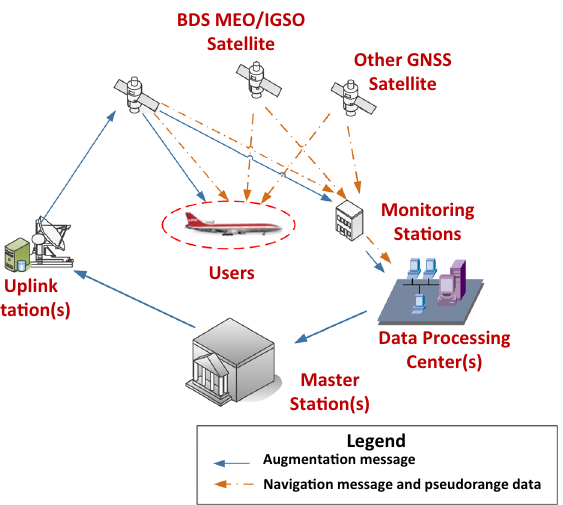
Figure 1. Illustration of the BDSBAS architecture. It consists of three parts: a space segment, which includes GEO satellites and other global navigation satellite system (GNSS) satellites; a ground segment, which includes monitoring stations, data processing centers, master stations and uplink stations; a user segment, which mainly includes the civil aviation